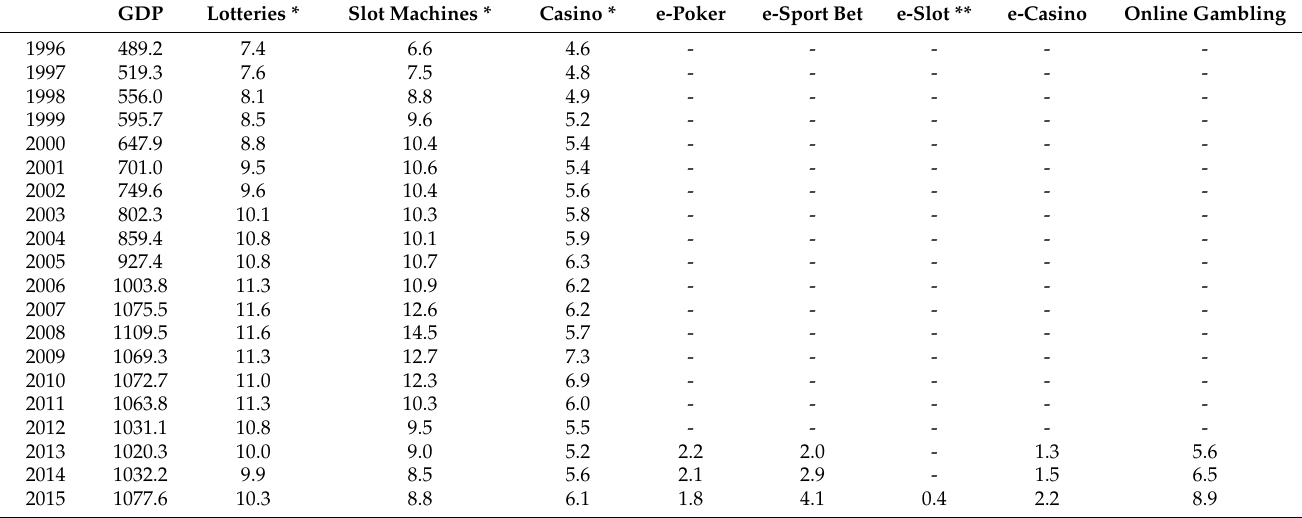
Table 2. GDP and gambling spending (billions of